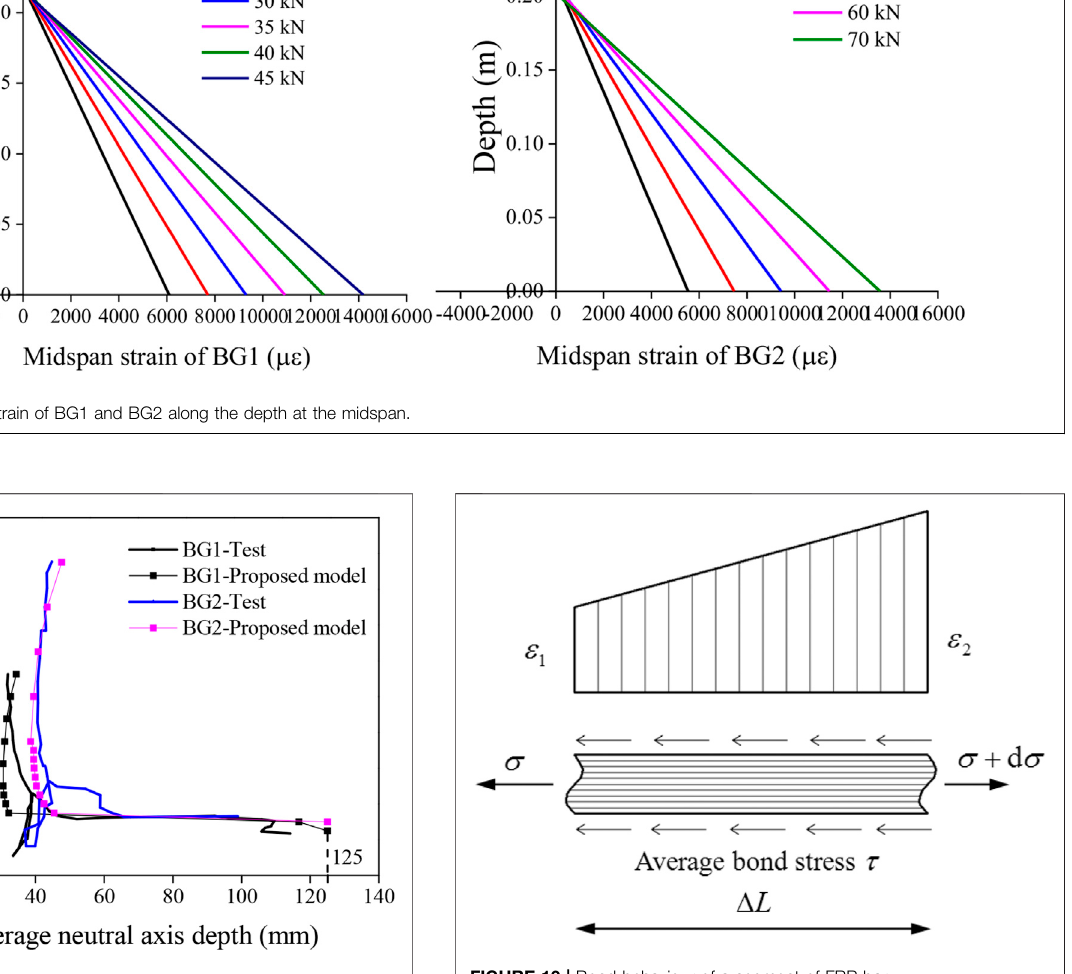
FIGURE 9 | Average neutral axis depth of BG1 and BG2.